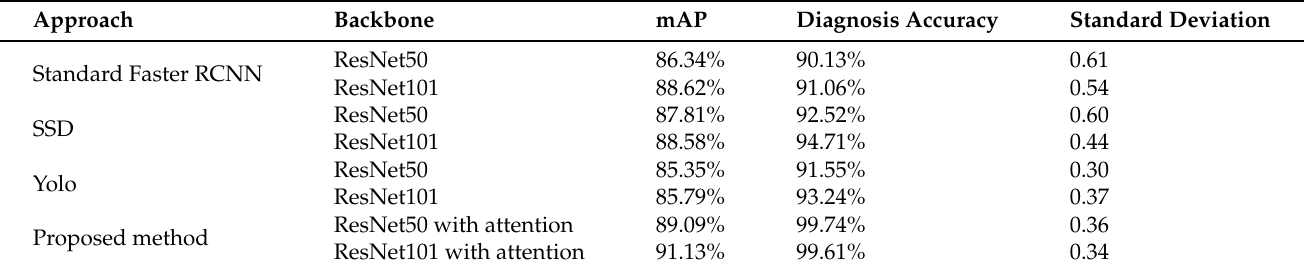
Table 3. Performance of comparison methods based on object detection.